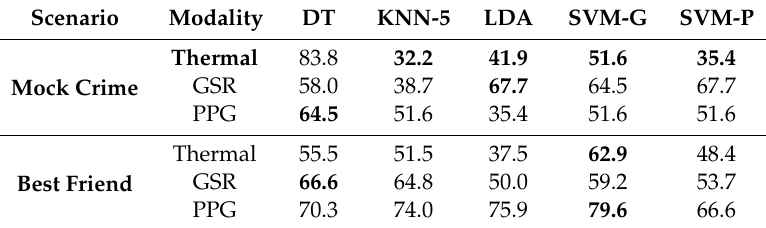
Table 2. Leave One Out cross validation results by three classifiers for all of thermal and physiological features in both protocols. The best results for all modalities were bolded.